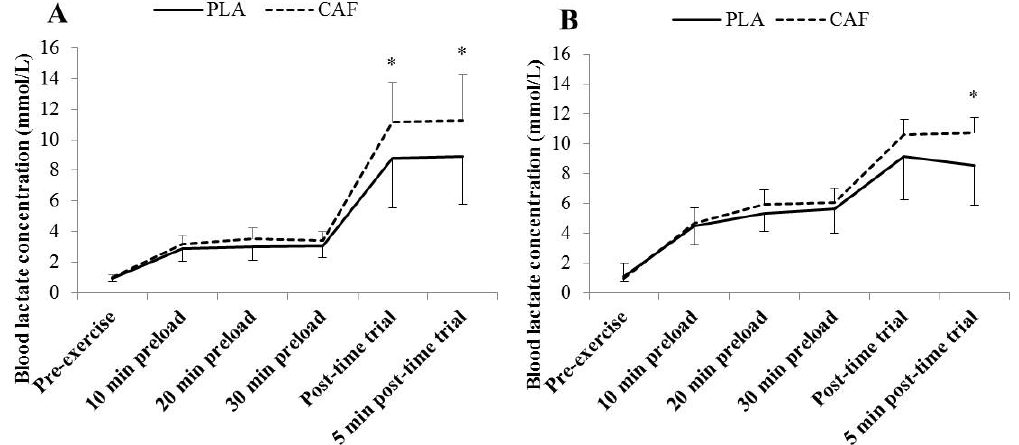
Figure 3. Group mean (SD) blood lactate concentrations (mmol/L) throughout the 30-min preloaded (65% V peak ) 10 km time trial protocol during cycling ( a ) and handcycling ( b ) following the consumption of 4 mg ∙ kg − 1 caffeine (CAF) or placebo (PLA). * Significantly different from placebo (PLA). Table 1. Overall, central and peripheral ratings of perceived exertion (RPE) at 10, 20 and 30 min during the preload and immediately post ‐ time trial.